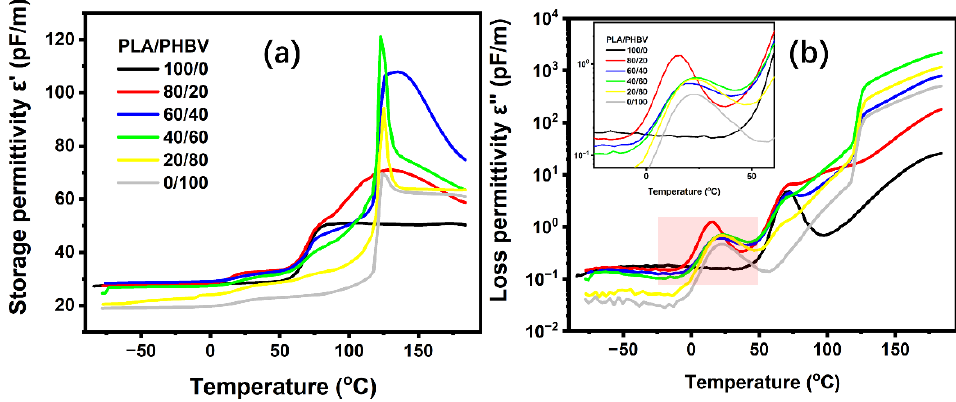
Figure 15. Temperature dependence of the storage permittivity ( ε (cid:48) ) ( a ) and loss permittivity ( ε (cid:48)(cid:48) ) ( b )